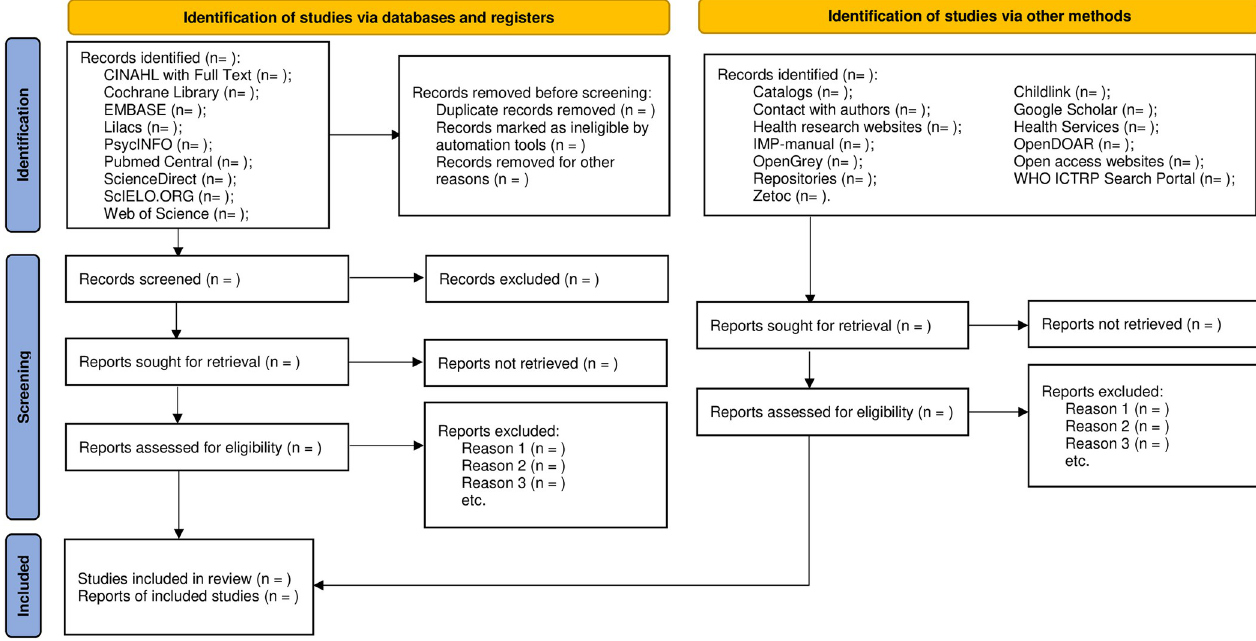
Fig 1. Flow diagram model, which will be used in the scoping review. Flow diagram based on the schematic overview of Flow Diagrams available at PRISMA.